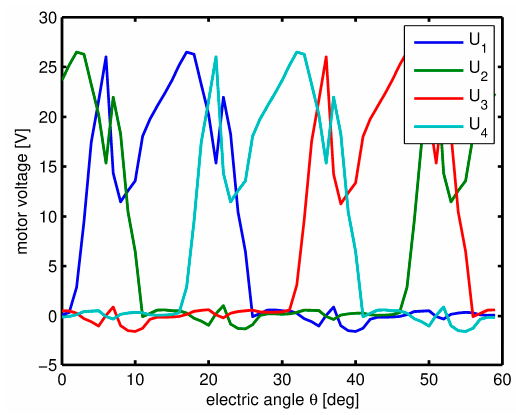
Figure 10. Voltage waveform found by optimization with weights: γ (cid:2915) = 1.0 , γ (cid:2931) = 0.1 , and γ (cid:2929) = 0.1 .